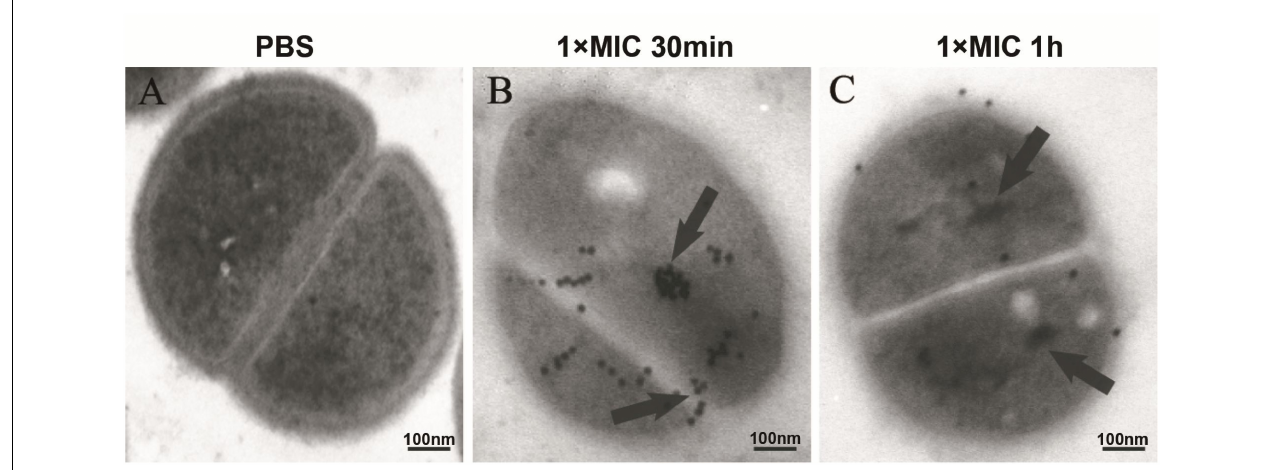
FIGURE 3 | Localization of DP7 in S. aureus by transmission electron microscopy. S. aureus ATCC 25923 (approximately 1 × 10 8 CFU/mL) were incubated with PBS (A) , or biotin-DP7 (1 × MIC) for 30 min (B) or for 1 h (C) . Fixed bacteria were then incubated with streptavidin (10 nm gold) for 1 h, and then observed under TEM. The length of the bars corresponds to 100 nm. ( n ≥